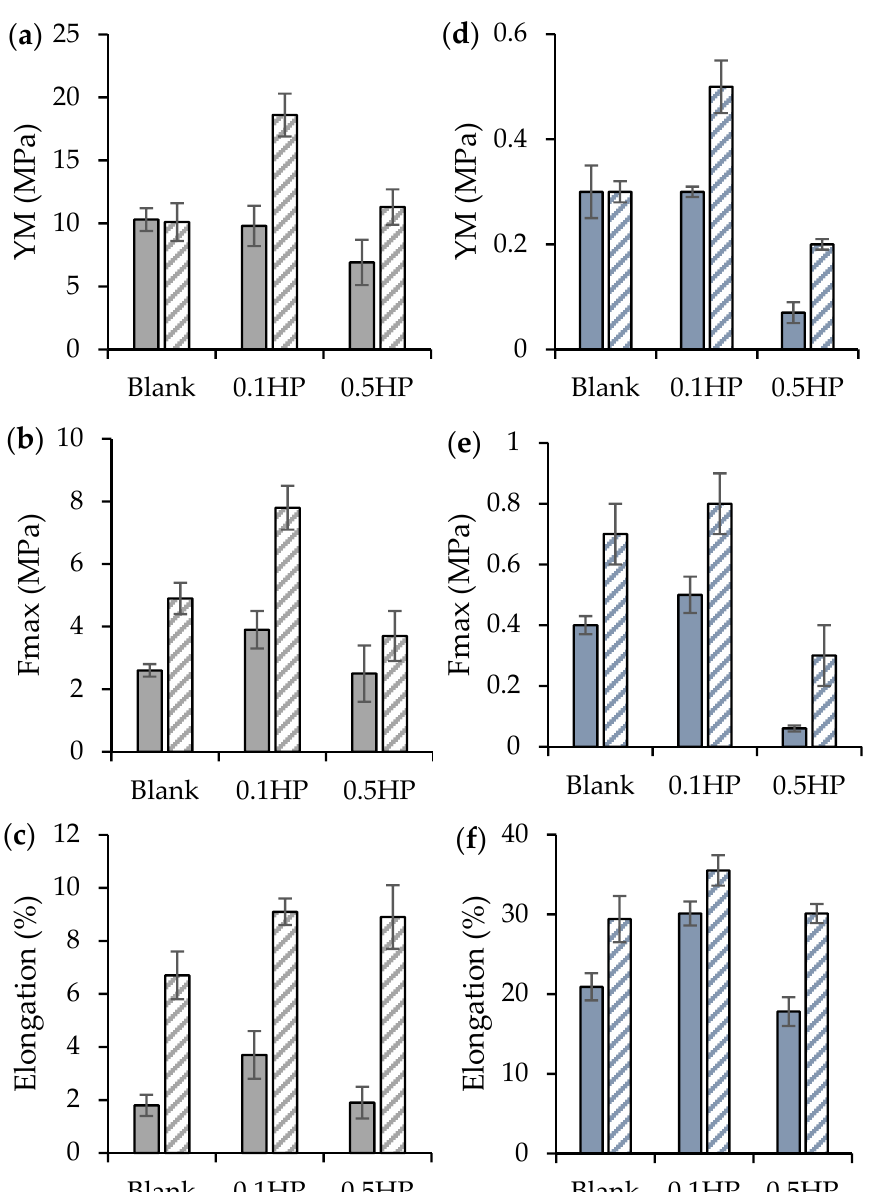
Figure 6. Mechanical properties of random (R, full color) and tubular aligned (A, shaded) scaffolds in the dry (top row) and hydrated (bottom row) states: ( a , d ): Young modulus (YM); ( b , e ): Fmax; ( c , f ): elongation at break (mean values ± s.d.; n = 4).